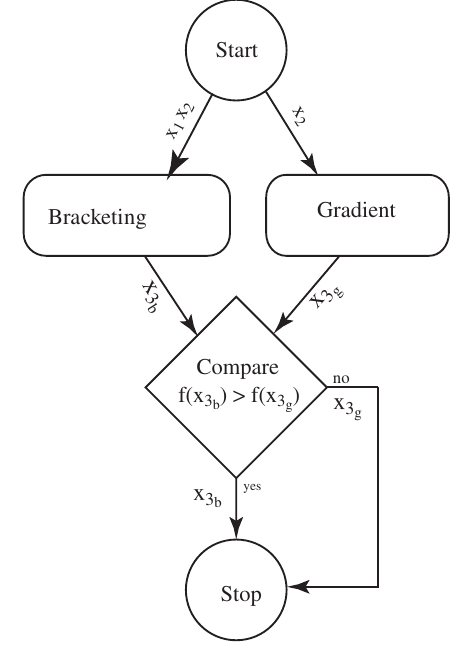
Fig. 7. Marginally cognitive optimization. Each process runs inde-